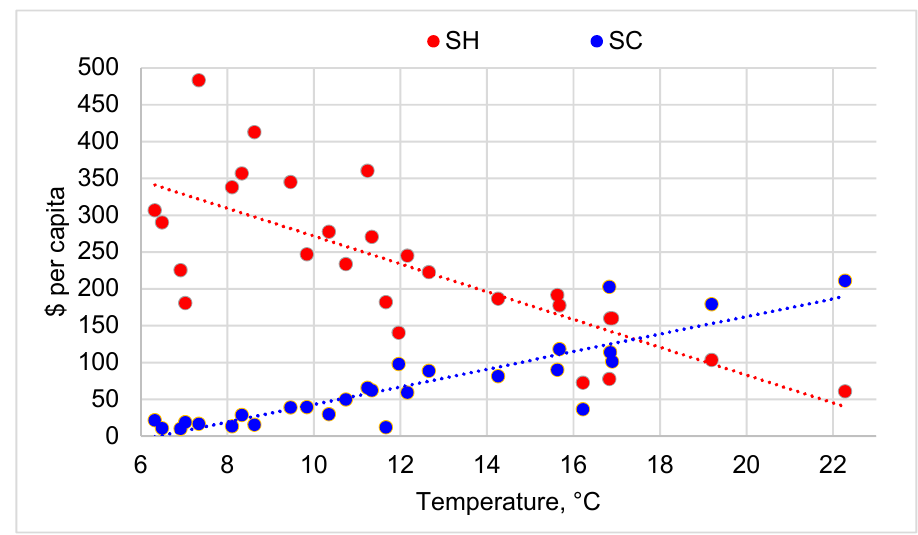
Figure 5. Residential per capita space heating and space cooling expenditure versus temperature at the population centroid, for the 27 states and state groups.